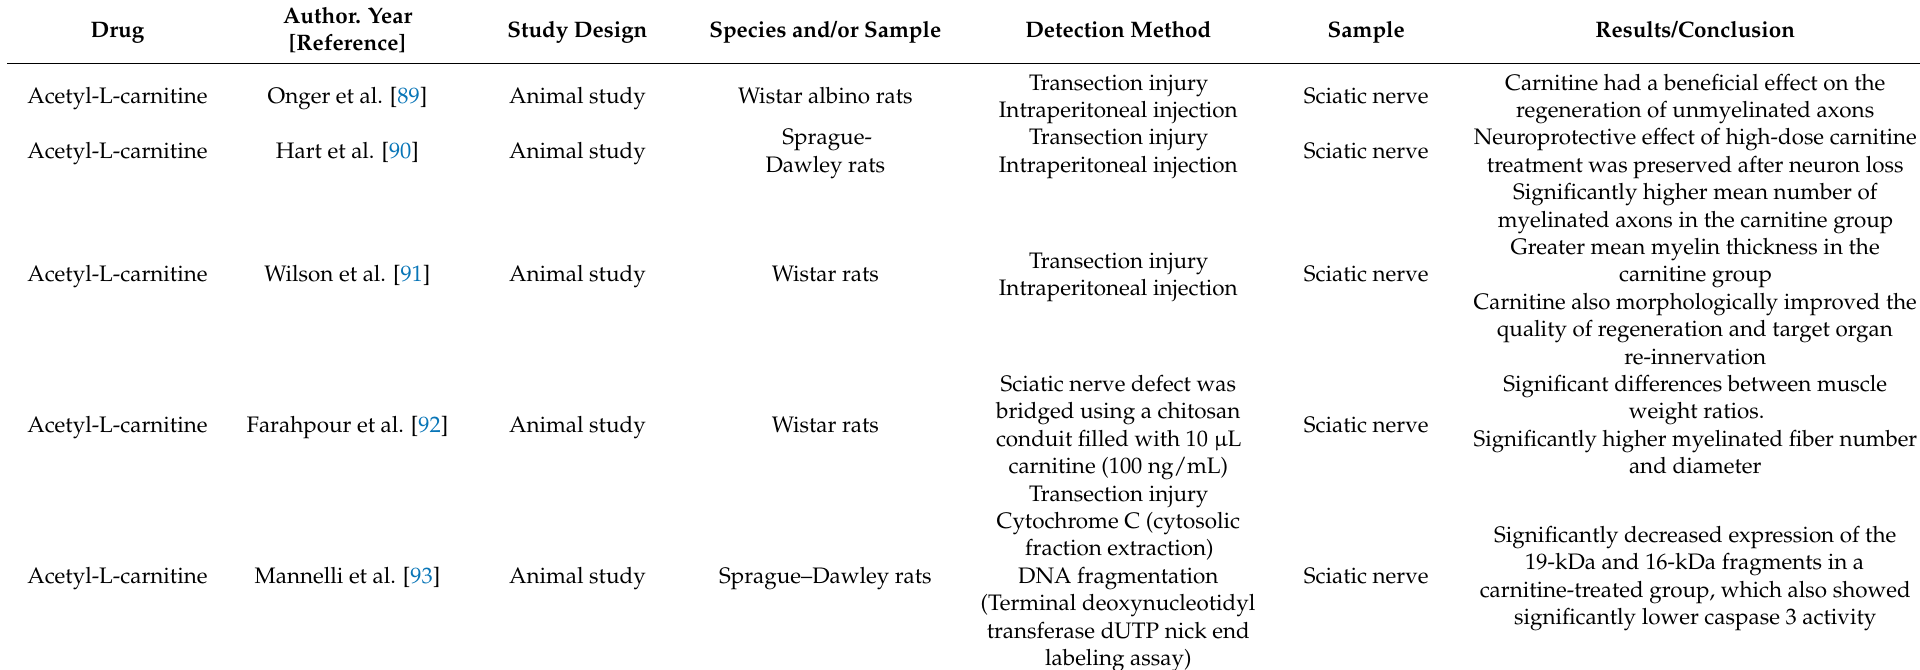
Table 6. Summary of studies assessing the use of carnitine for the treatment of peripheral nerve